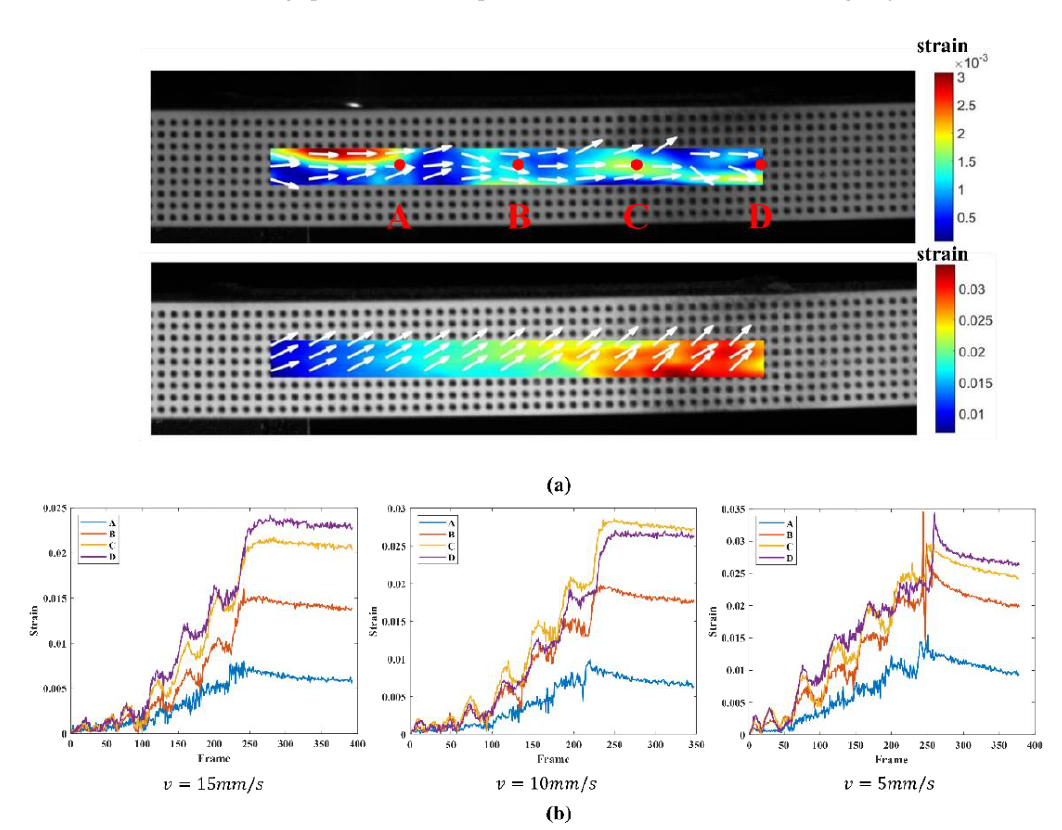
Figure 18. ( a ) The equivalent strain field at the beginning and end of printing at 10 mm/s and ( b ) variation curve of equal effect change at four points A, B, C and D with time.